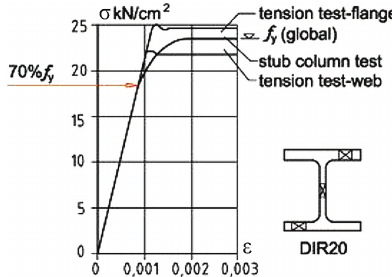
Fig. 4. Influence of residual stresses on the material behaviour